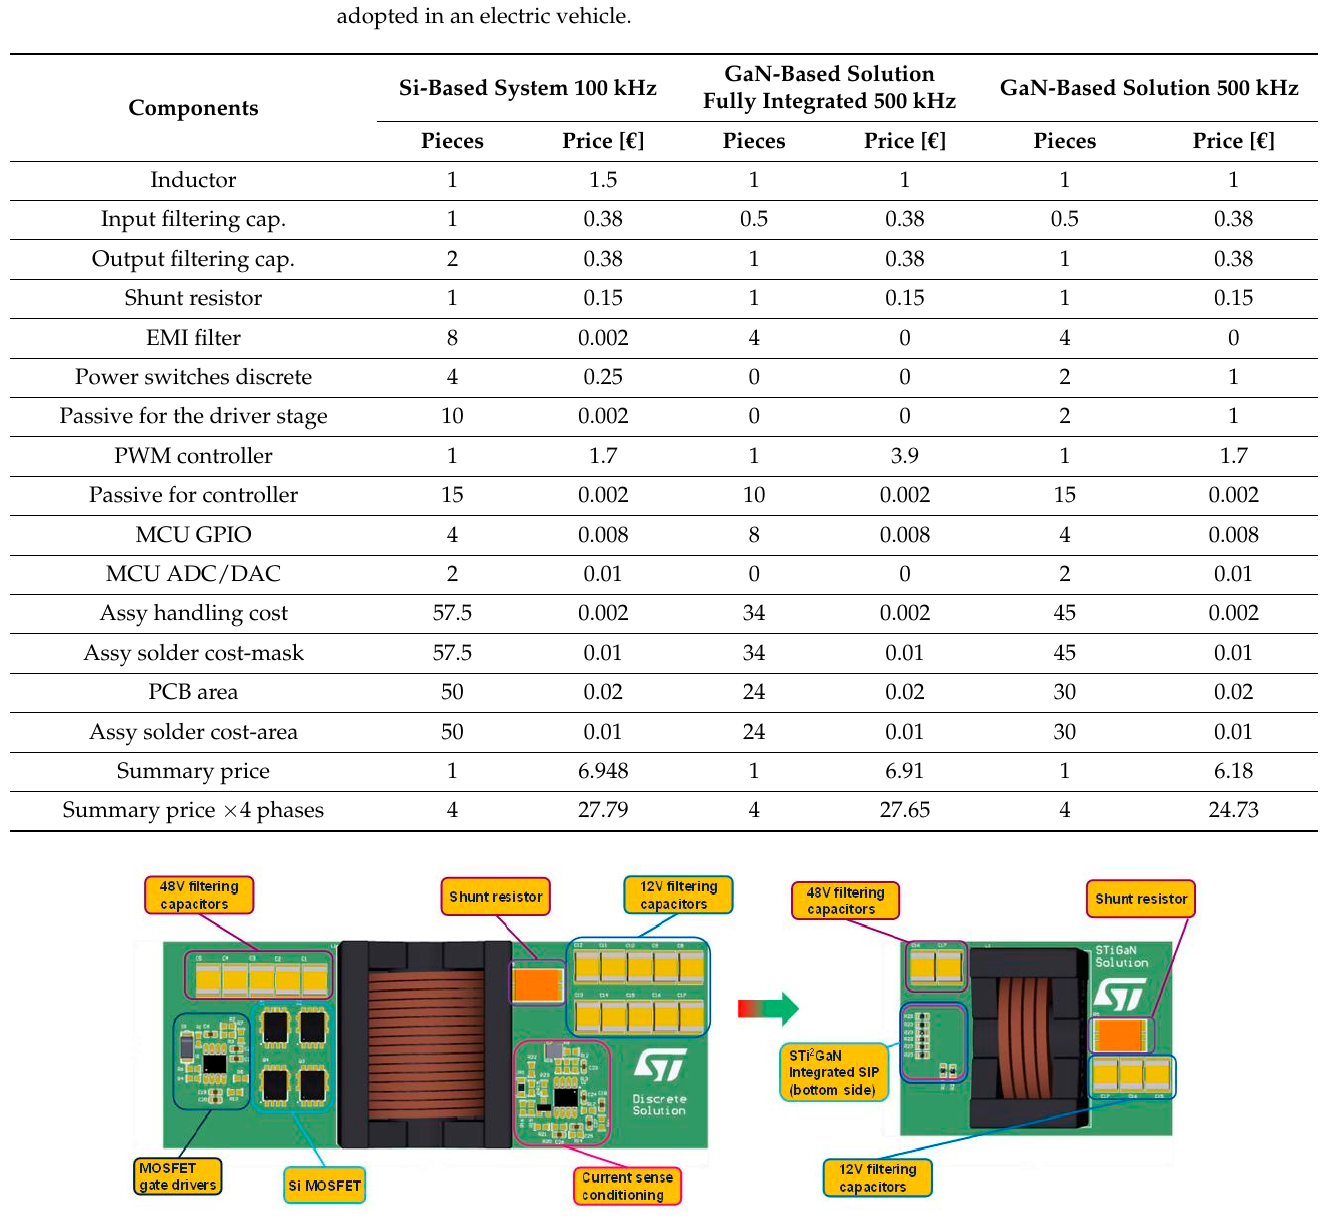
Figure 1. Area reduction by increasing the switching frequency.